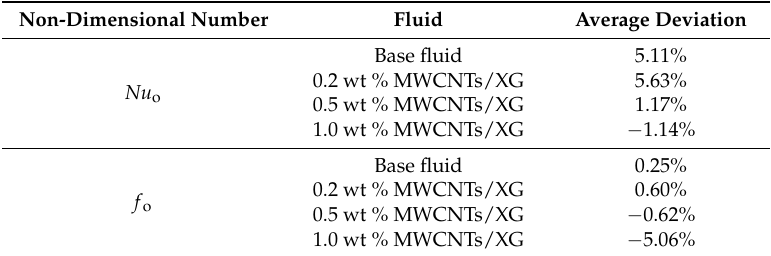
Table 2. Average deviations of Nu o and f o between experimental and numerical data.